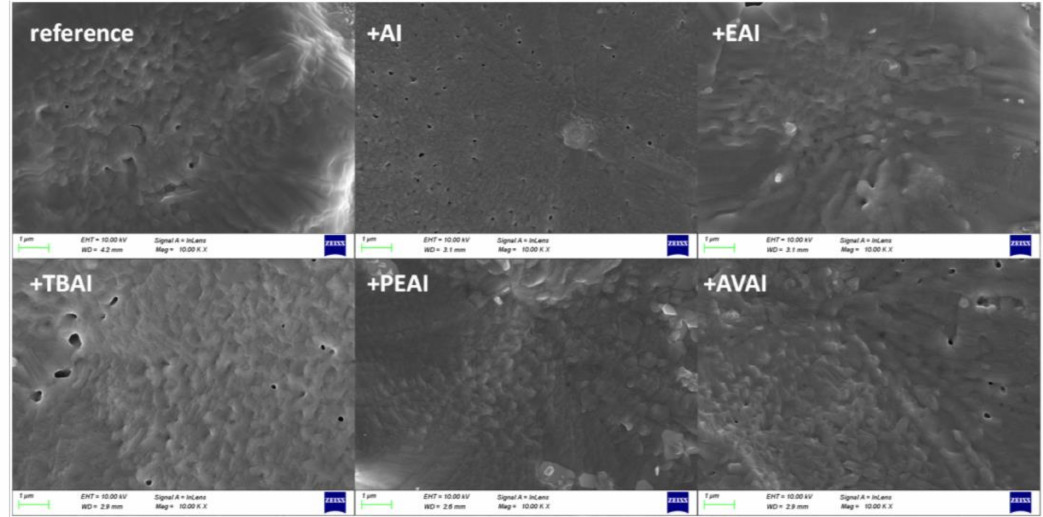
Figure 3. Top view SEM images obtained for the perovskite films with and without the ammonium iodides additives in the perovskite precursor solution.